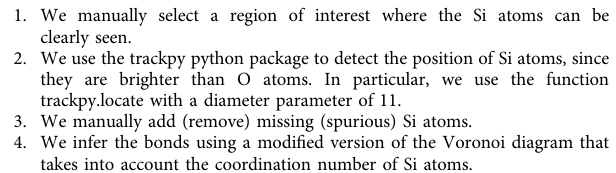
Fig. 6c – e, taken from ref. 23 , as